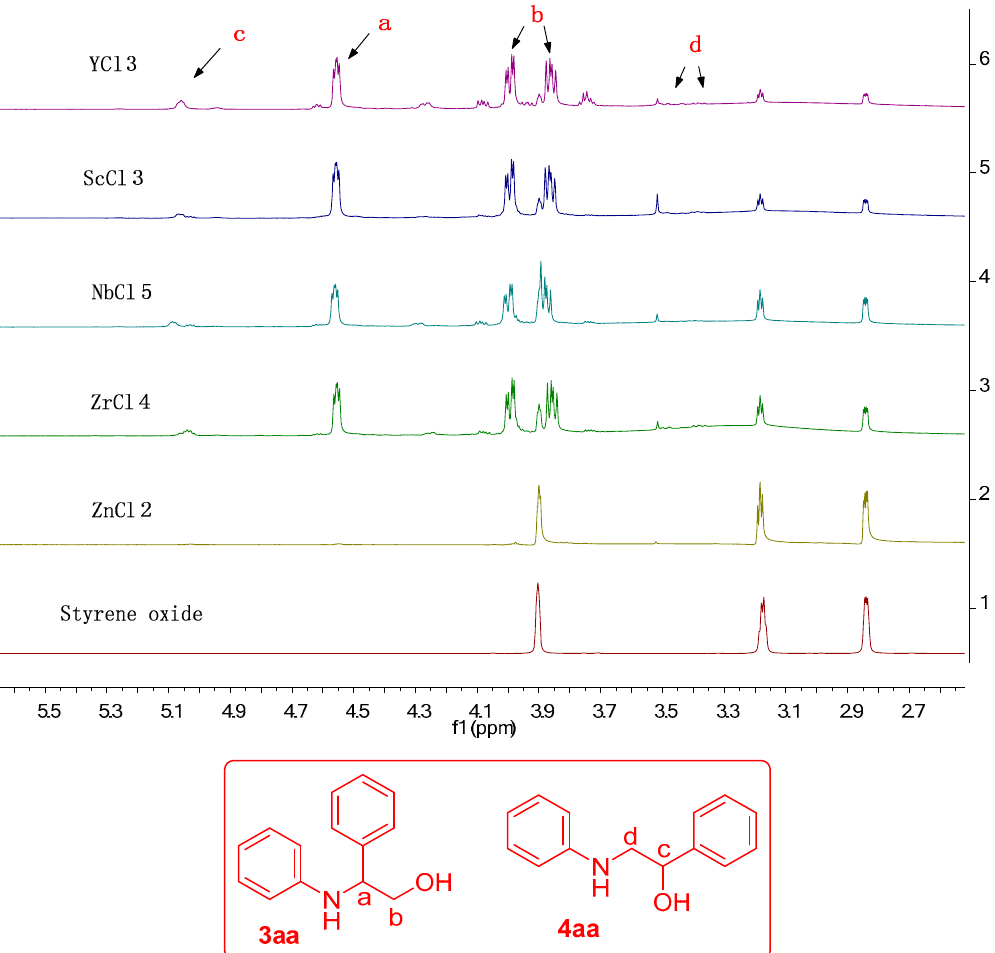
Figure 1. Comparative analysis of 1 H-NMR spectra of crude mixtures of regioselective ring-opening reaction of styrene oxide ( 1a ) with aniline ( 2a ) using different metal catalysts to give ( 3aa ) and ( 4aa ). The regioisomer ( 3aa ) forms predominantly, as can be observed from spectra. The letters a, b, c, and d indicate the peaks or peak region corresponding to protons on carbons indicated by a, b, c and d in chemical structures of 3aa and 4aa . Reaction conditions: 1a (1 equiv.), 2a (1 equiv.), catalyst (1 mol %), RT, 1 h.